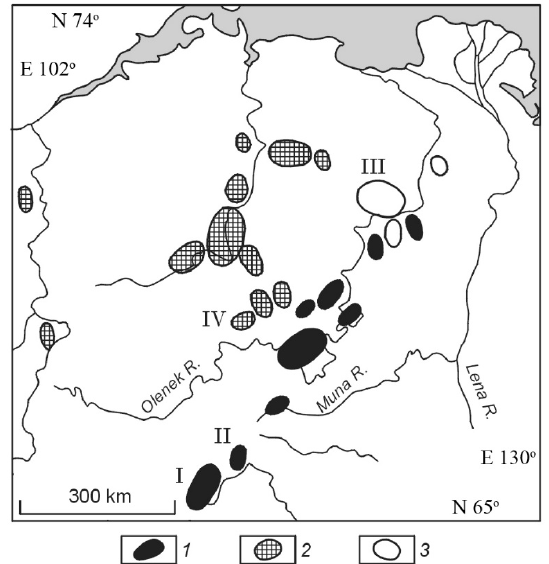
Figure 4. Location map of the northeastern Siberian craton, with kimberlite fields of different ages: 1,